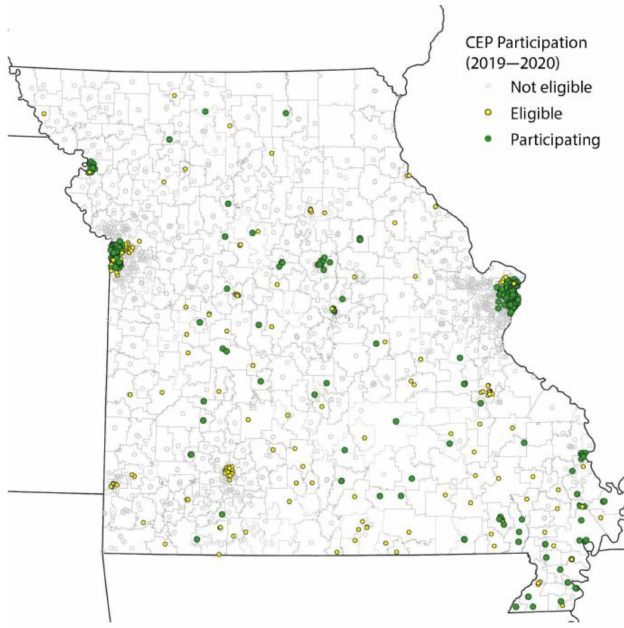
Figure 1. School CEP status (2019–2020). Similarly, BATB participation was highly concentrated in urban areas, such as St. Louis City (Figure 2).